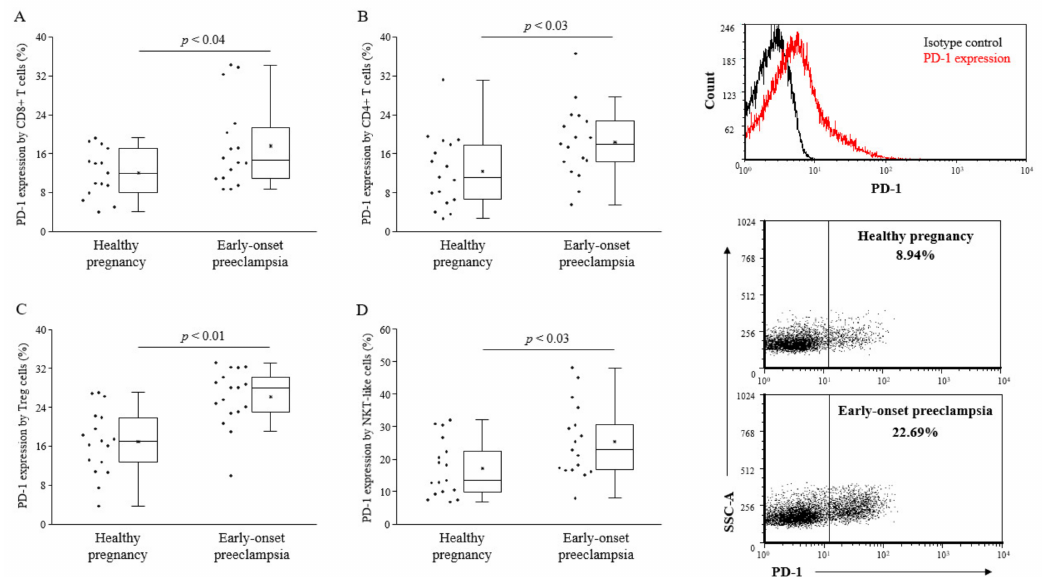
Figure 1. Programmed death-1 (PD-1) expression by peripheral lymphocyte populations in 3rd-trimester healthy pregnant women and in women with early-onset preeclampsia. The expression of PD-1 by CD8+ T cells ( A ), CD4+ T cells ( B ), Treg cells ( C ) and NKT-like cells ( D ) in peripheral blood of women with early-onset preeclampsia and in healthy pregnant women. The solid bars represent medians of 17 and 17 determinations, respectively, the boxes indicate the interquartile ranges, and the lines show the most extreme observations. Differences were considered statistically significant for p -values ≤ 0.05.